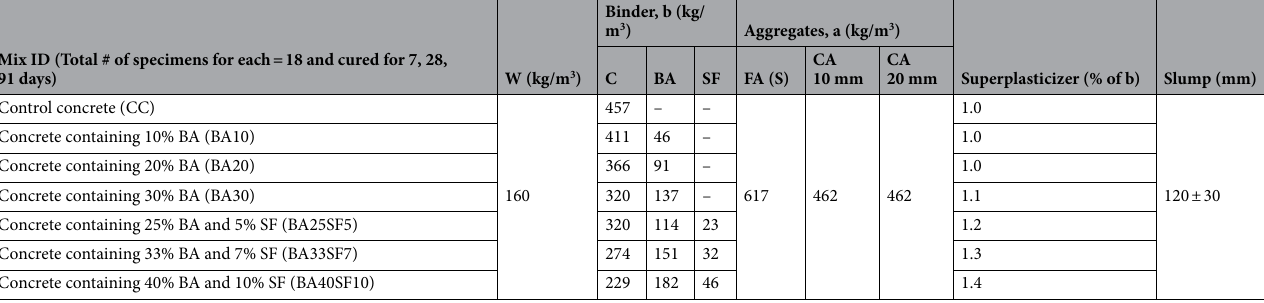
Table 3. Mixture proportions of concrete samples for compressive and tensile tests, water absorption, and porosity (w/b = 0.35; a/b = 3.37; s/a =